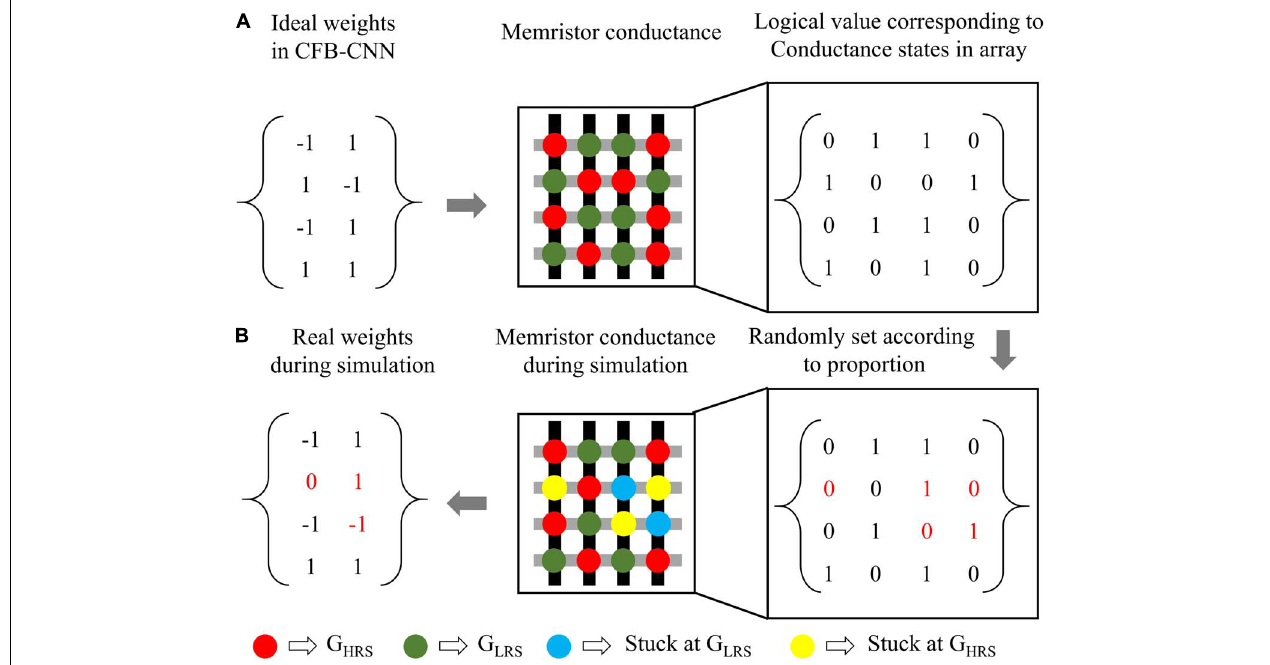
FIGURE 9 | The illustration of the simulation process about yield problem, (A) relationship between the weights in CFB-CNN architecture and conductance states in memristor array, (B) description about how to simulate the damaged device in